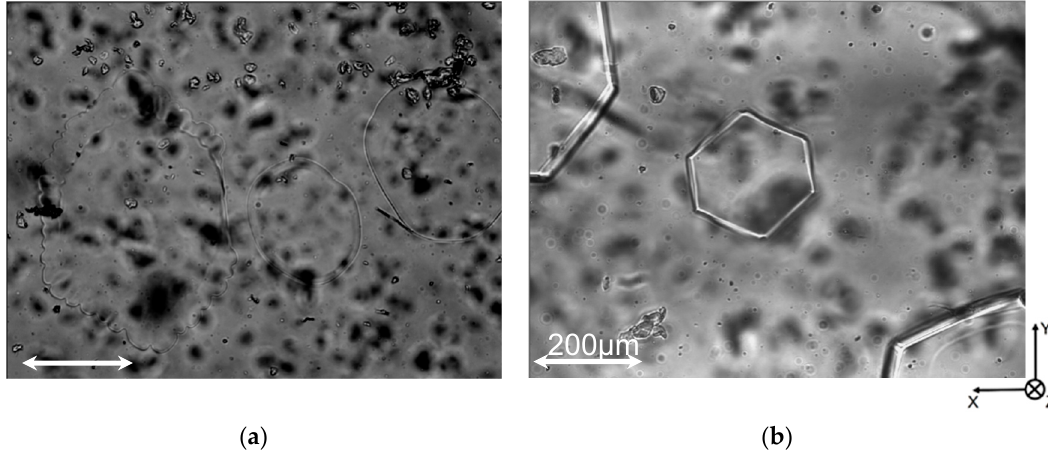
Figure 5. Typical ice particles observed in the flow of ice slurry. ( a ) In the case of c = 0 mg/mL; ( b ) In the case of c = 0.25 mg/mL.